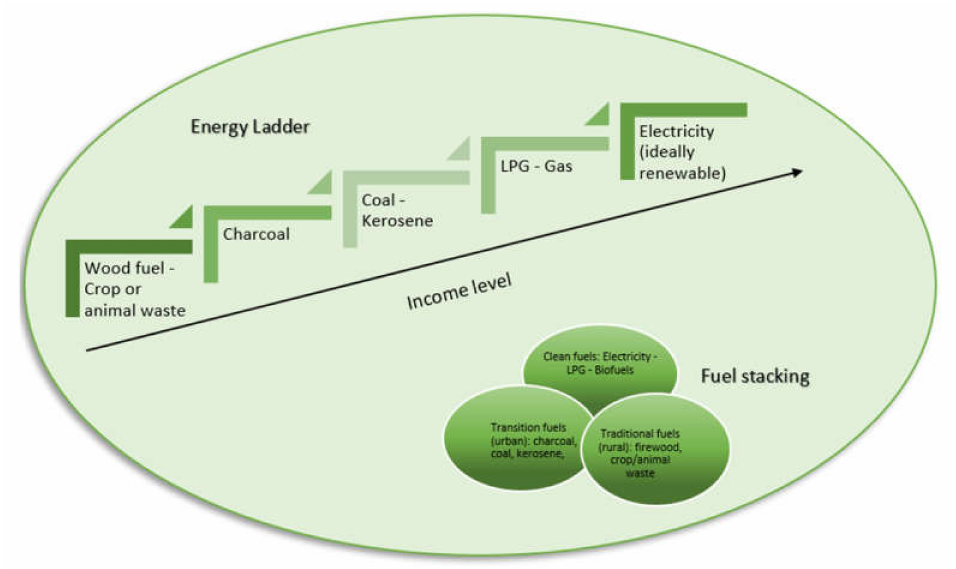
Figure 1. The energy ladder and fuel-stacking models (Authors’